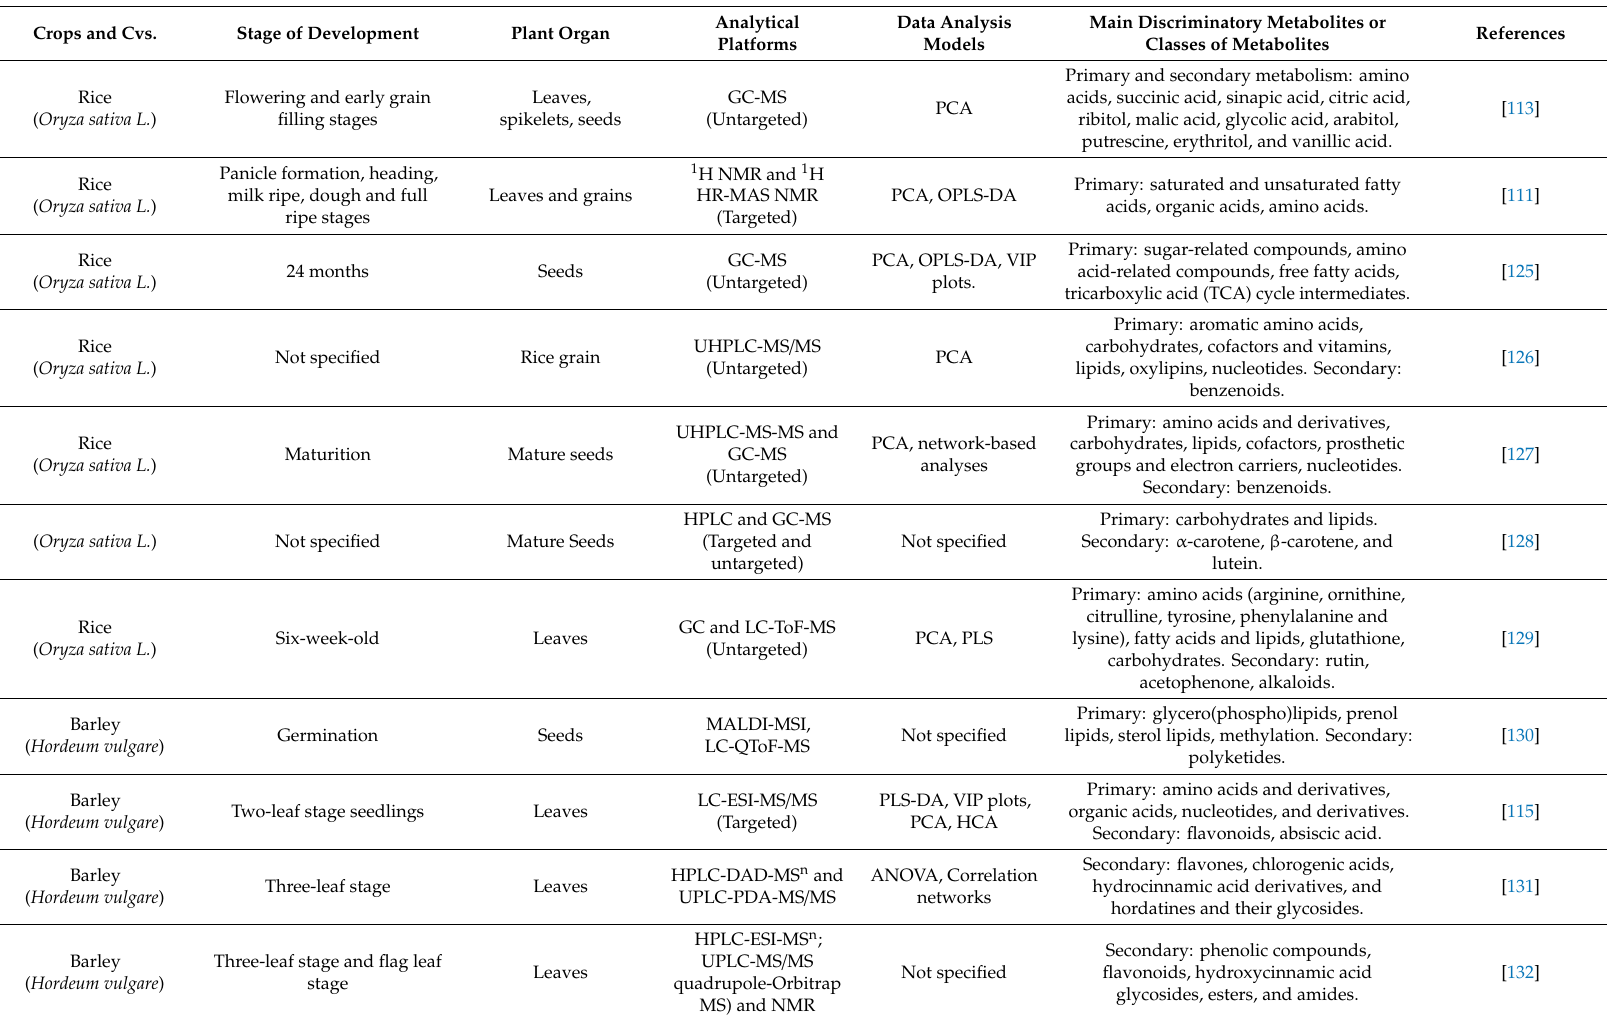
Table 1. List of plants / crops where metabolomics was applied as a tool in cultivar identification or improvement. Crops and